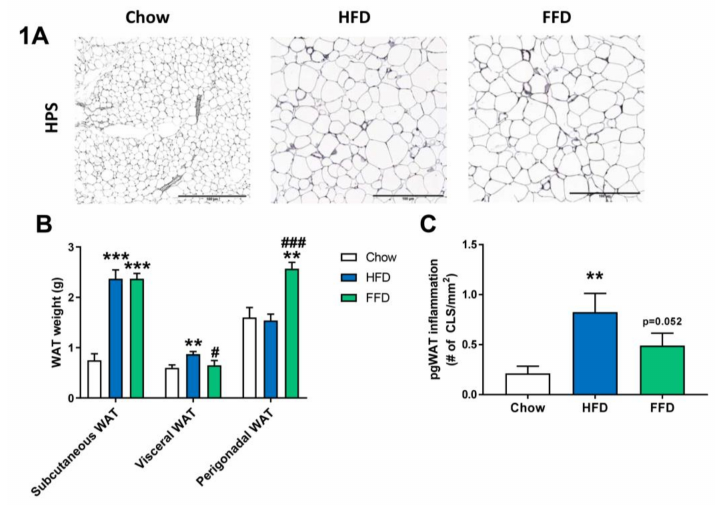
Figure 1. Representative images of perigonadal white adipose tissue (WAT) cross-sections ( A ) stained with hematoxylin–phloxine–sa ff ron (HPS) and WAT weight of di ff erent adipose tissue depots ( B )